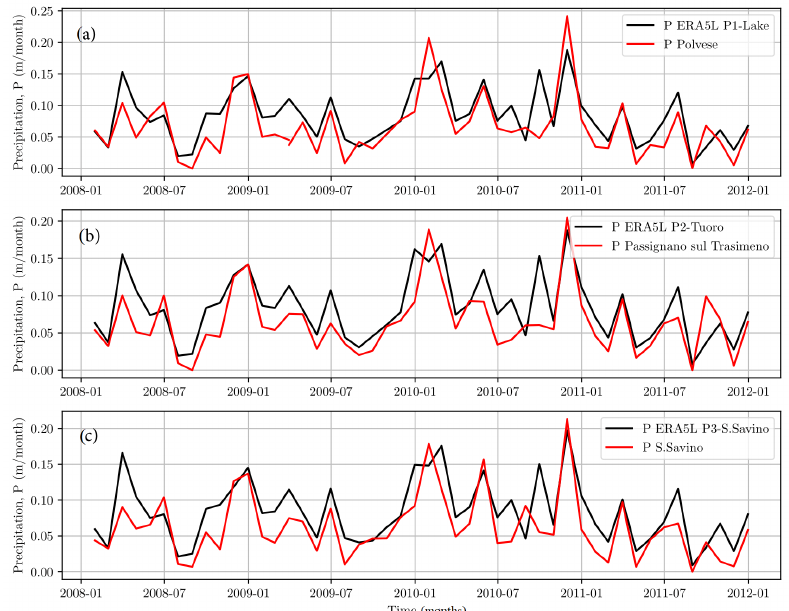
Figure 6. Comparison for the period 2008–2011 between the precipitation over the lake, P (m/month), observed at ground base by weather stations (reported in red), and the one, provided by ERA5L (in black), at: ( a ) P1-Lake vs. Polvese, ( b ) P2-Tuoro vs. Passignano sul Trasimeno, and ( c ) P3-S. Savino vs. S. Savino.